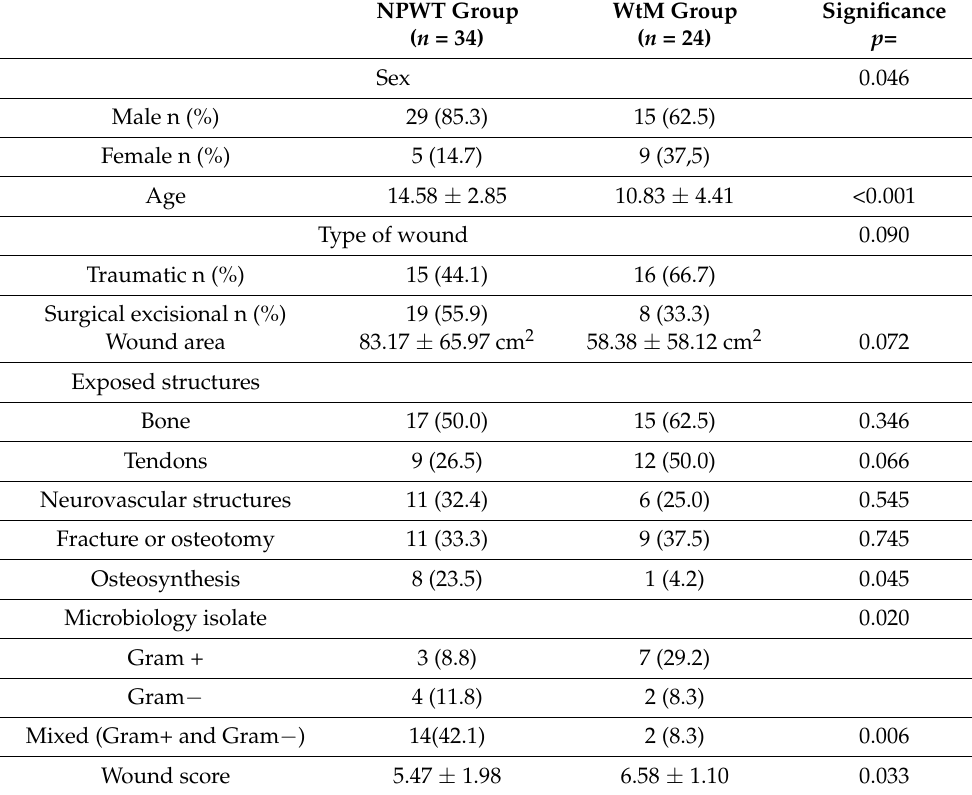
Table 1. Patients demographics and wound characteristics.